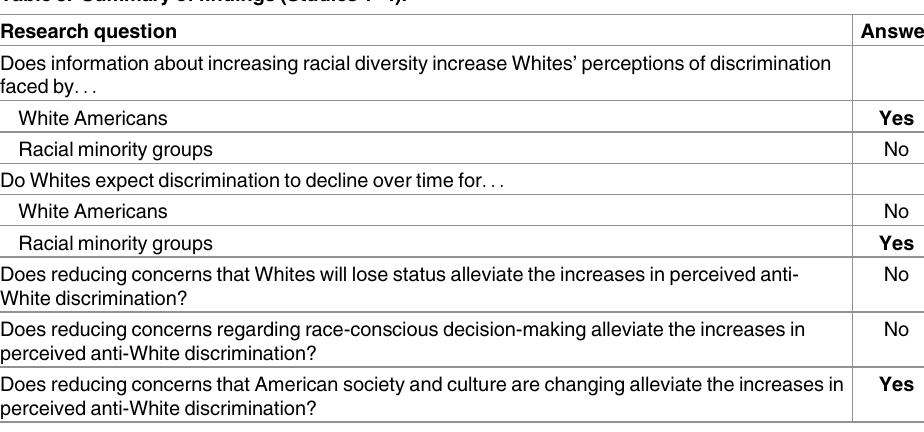
Table 3. Summary of findings (Studies